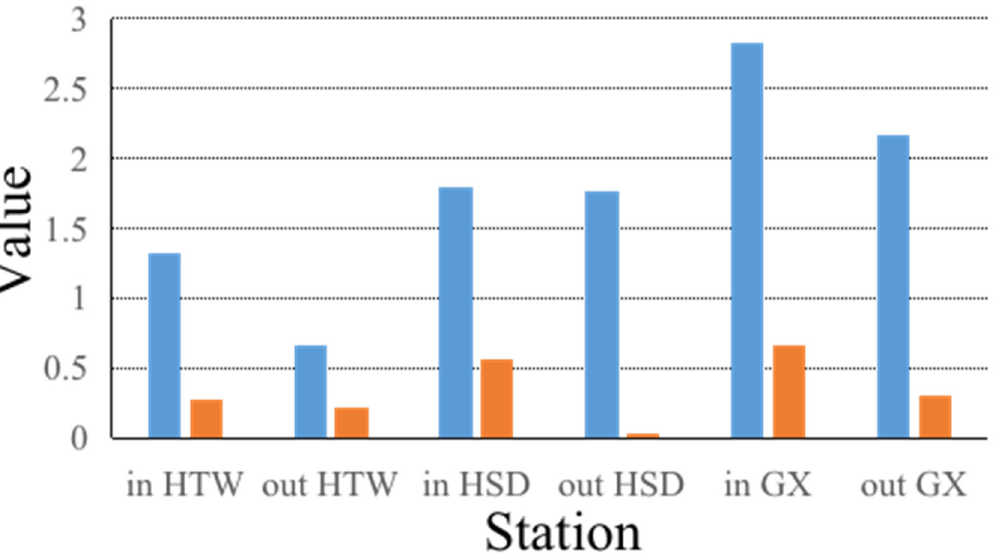
Figure 5. Relationships between light attenuation rate k (unit: m − 1 ) and fish juvenile number density (unit: ind m − 2 per day) classified by inside and outside of Sargassum horneri beds and by sites (Houtouwan, Huangshidong, and Ganxie). The value in y -axis represents the value of light attenuation rate k and fish juvenile number density. ‘In’ means inside the bed; ‘Out’ means outside the bed.